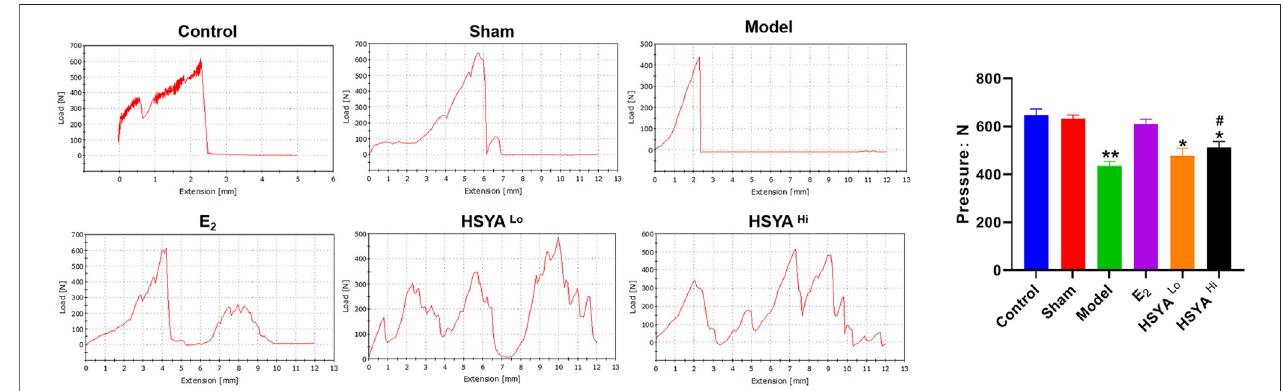
FIGURE 3 | Maximum weight-bearing threshold of the right leg femur in rats tested by INSTRON, with quanti fi ed results on the right. The horizontal coordinates indicatethedistancethattheupperplatenoftheinstrumentcontinuedtomovedownwardaftertouchingthefemur. “ ** ” indicates p < 0.01, “ * ” indicates p < 0.05,andthe difference is statistically signi fi cant compared to the control group. “ # ” indicates p < 0.05, and the difference is statistically signi fi cant when compared with the model